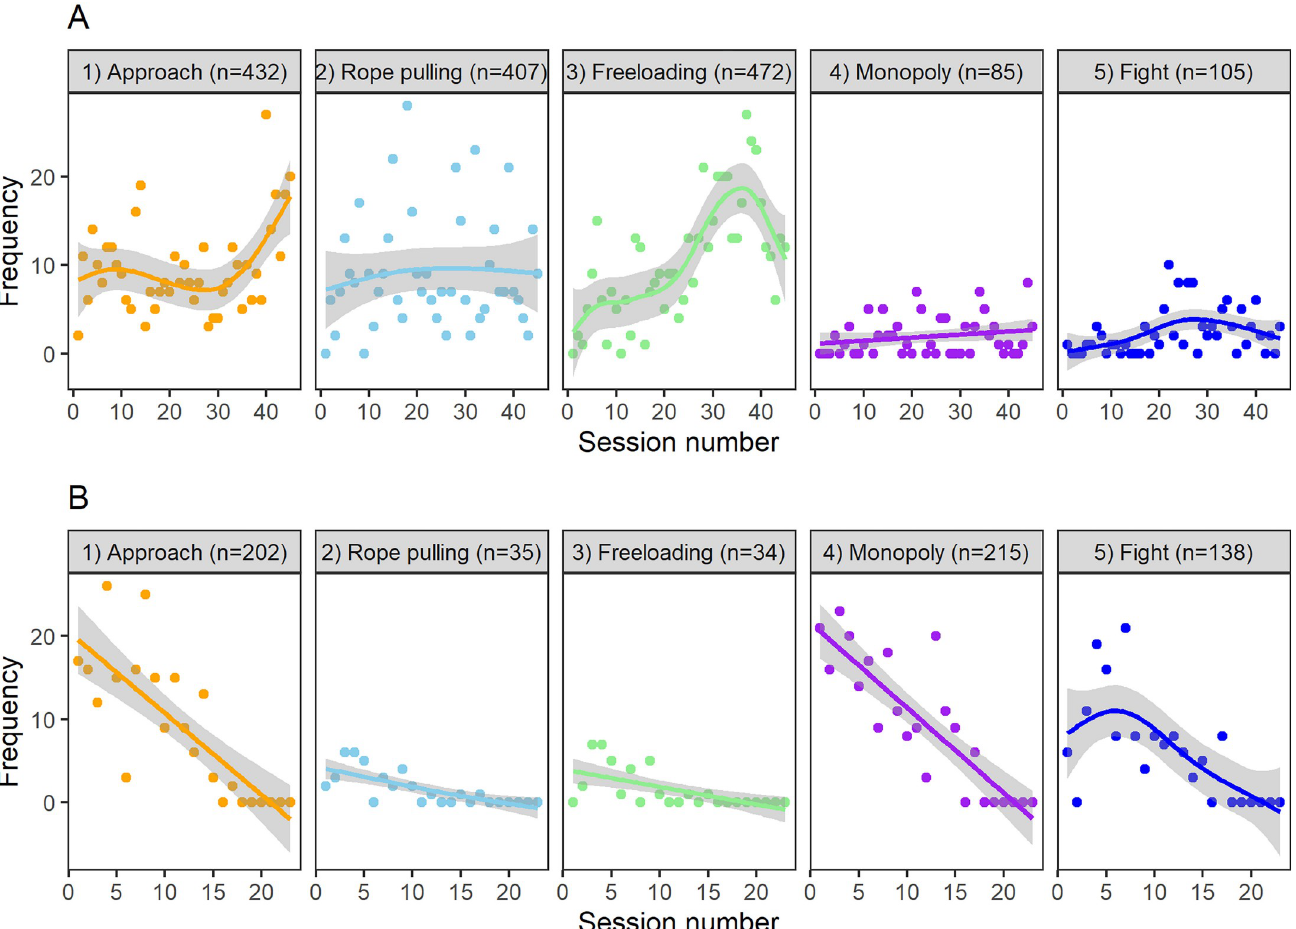
Fig 2. Change in competition behaviors over time in the 2-tray Phase I (A) and 1-tray Phase II (B). Each point represents the frequency of a competition behavior in each session. Different colors represent different types of competition behaviors, while gray shading represents 95% confidence intervals. The perceived cost of each type of competition behavior increases from left to right, with approach being least costly and fight being most costly. While the cooperation rate remained stable across the 2-tray Phase I, it decreased rapidly in 1-tray Phase II, which contributed to the decreasing frequency of each competition behavior across Phase II (i.e., when cooperation happened less frequently or not at all, there was less or no food, respectively, for which to compete). The data used to generate this figure can be found in S1 Data.